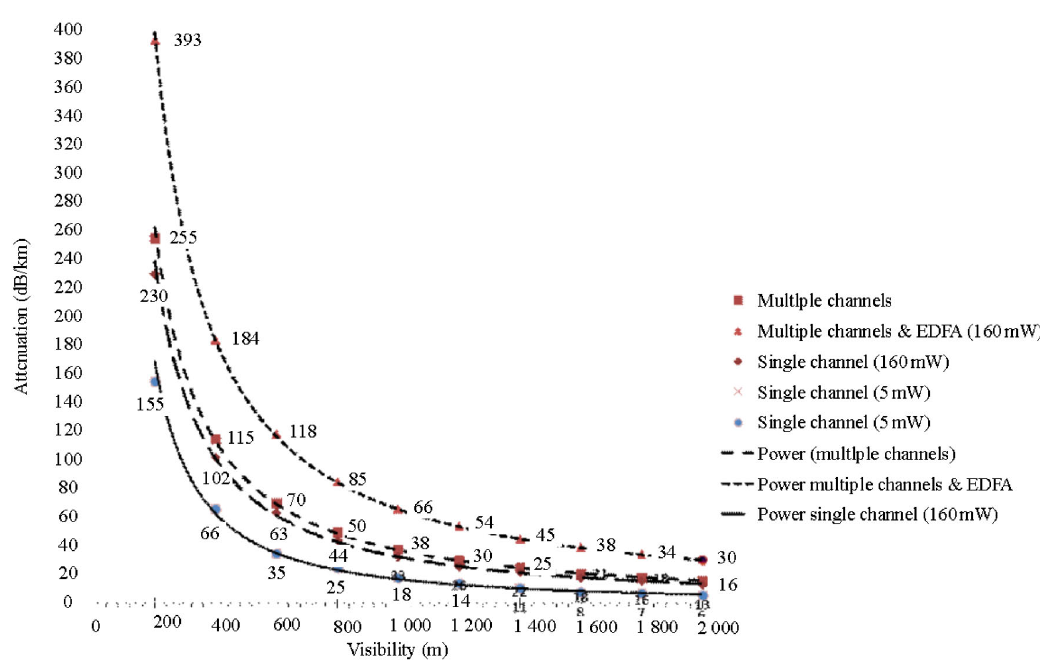
Fig. 4 Variation of the attenuation at 1550 nm in the function of visibility, compared, using the Kim